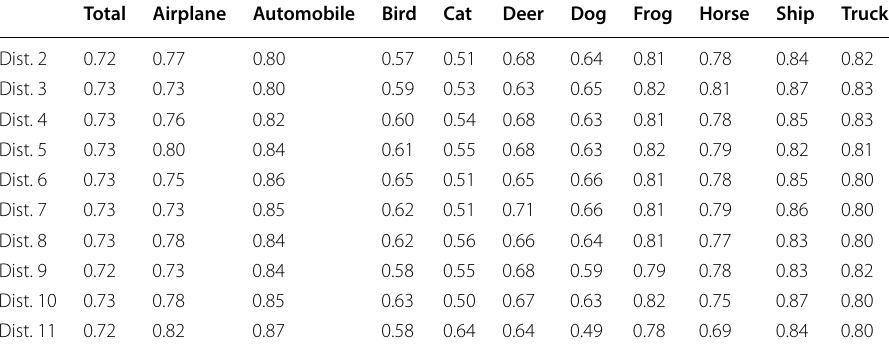
Table 4 Imbalanced CIFAR-10 classification with ROS [79] Total Airplane Automobile Bird Deer